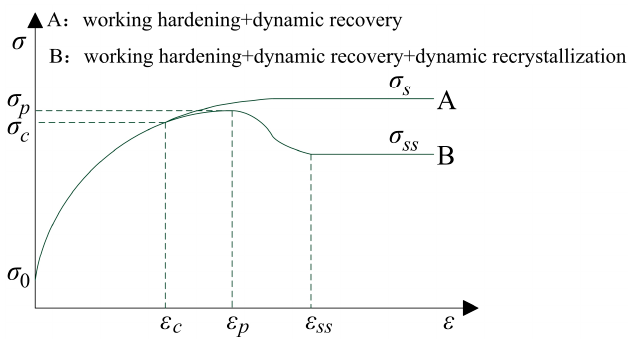
Figure 5. Typical flow stress curves for hot working.